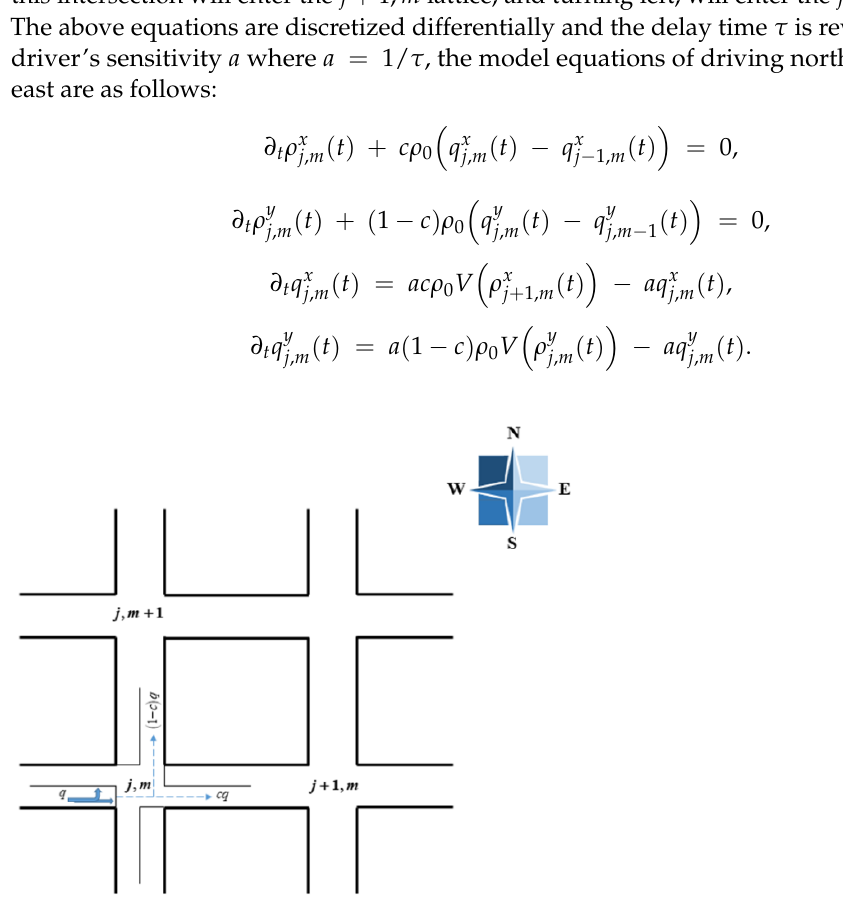
Figure 1. Schematic model of traffic flow on a two-dimensional highway.